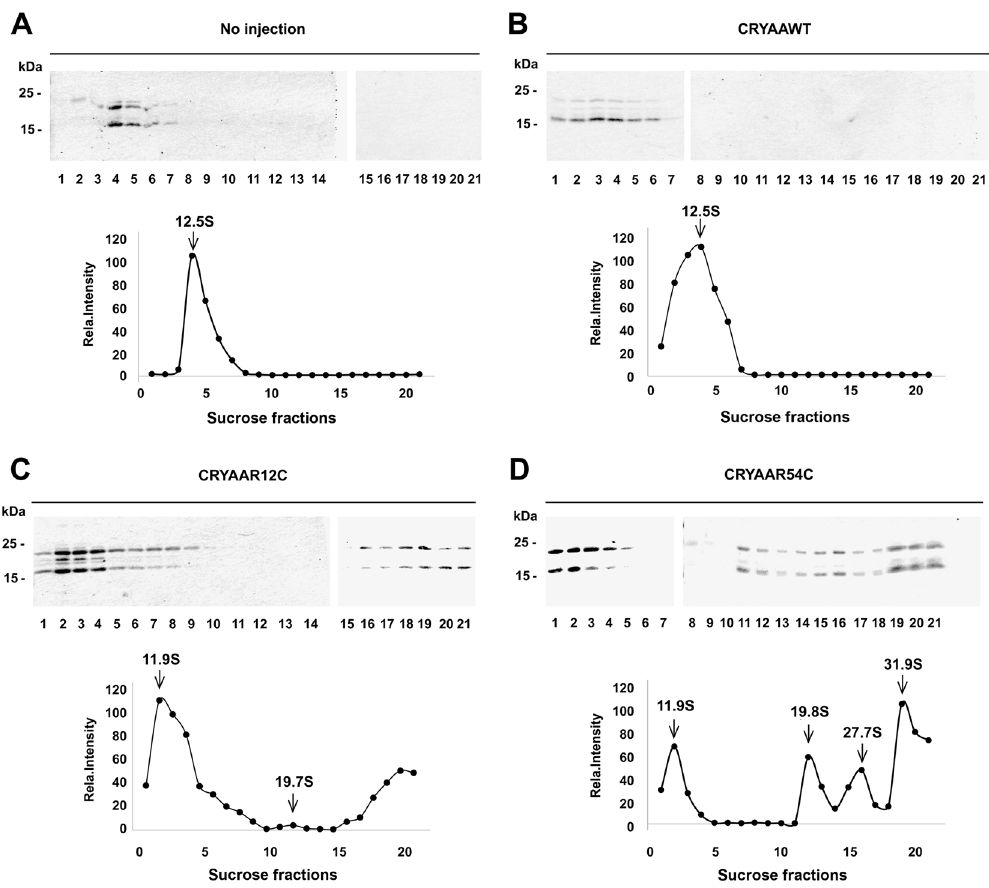
Fig. 8 Protein aggregation results from human crystalline mutations exogenously expressed in the embryonic chick lens. Embryonic chick lenses without injection ( A ) or injected with recombinant RCAS(A) expressing WT human α A-crystalline (hCRYAA) ( B ), or one of two mutations, hCRYAAR12C ( C ), and hCRYAAR54C ( D ). Lysate of E20 lenses was prepared and fractionated on a linear gradient of 4 – 20% sucrose. Each fraction was subjected to SDS/PAGE and western-blotted with an anti- α A-crystallin antibody (upper panels). The sedimentation coef fi cients were calculated and the band intensity of α A-crystalline in each gradient fraction on western blots was quanti fi ed by Image J. and normalized as a percentage of the fraction containing the highest level of hCRYAA or mutations, respectively (bottom